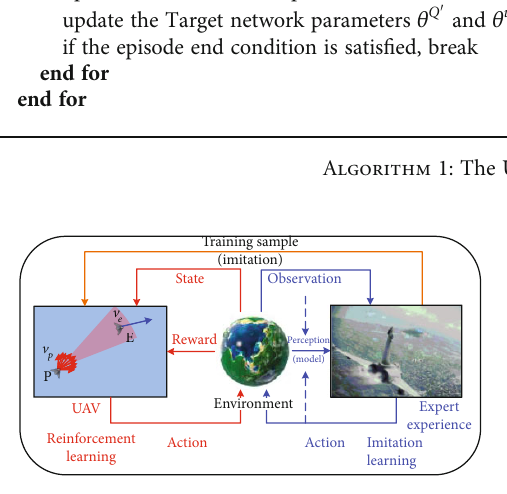
Figure 3: The algorithm framework based on